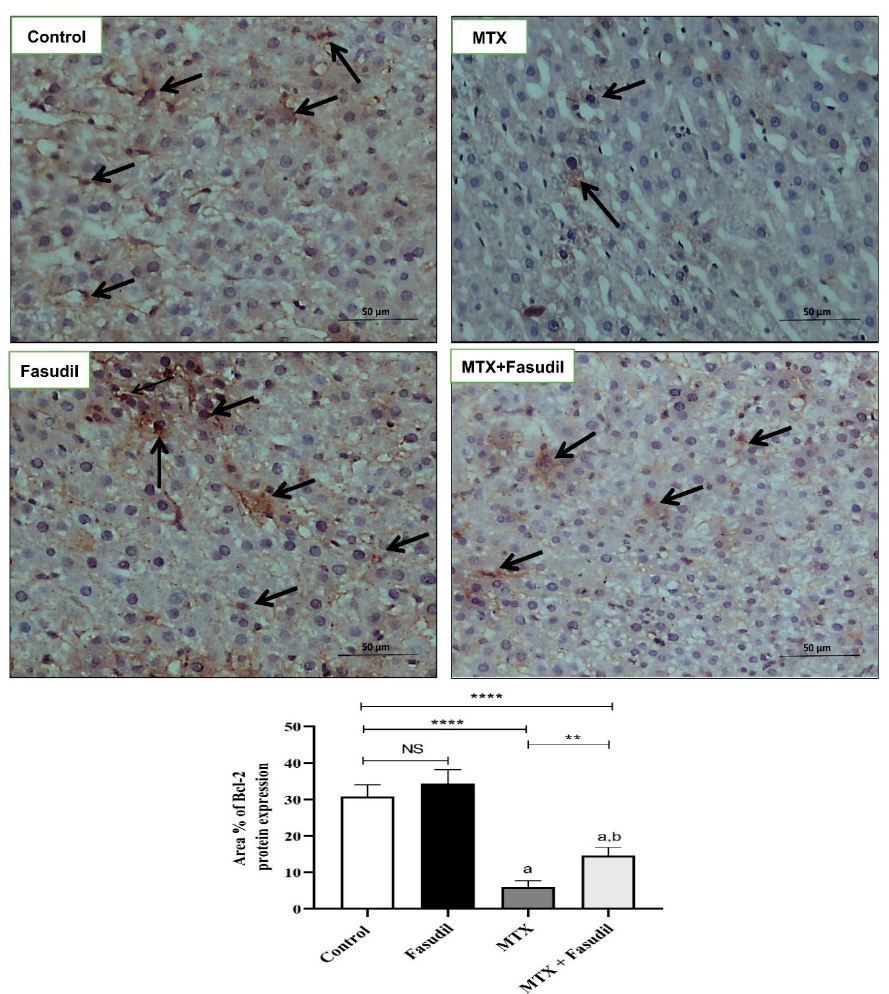
Figure 7. Effect of fasudil on Bcl-2 immunostaining protein expression after MTX-challenge (IHC X 400). Arrows indicate the localization and expression of Bcl-2 in hepatic sections. Scale bar = 200 μ m. The bar graph represents the quantitative determination of Bcl-2 protein expression in different groups ( n = 6); a: significant difference from the control group ( p < 0.05); b: significant difference from the MTX group ( p < 0.05). ** p < 0.05. *** p < 0.001. **** p < 0.0001. NS, non-significant.